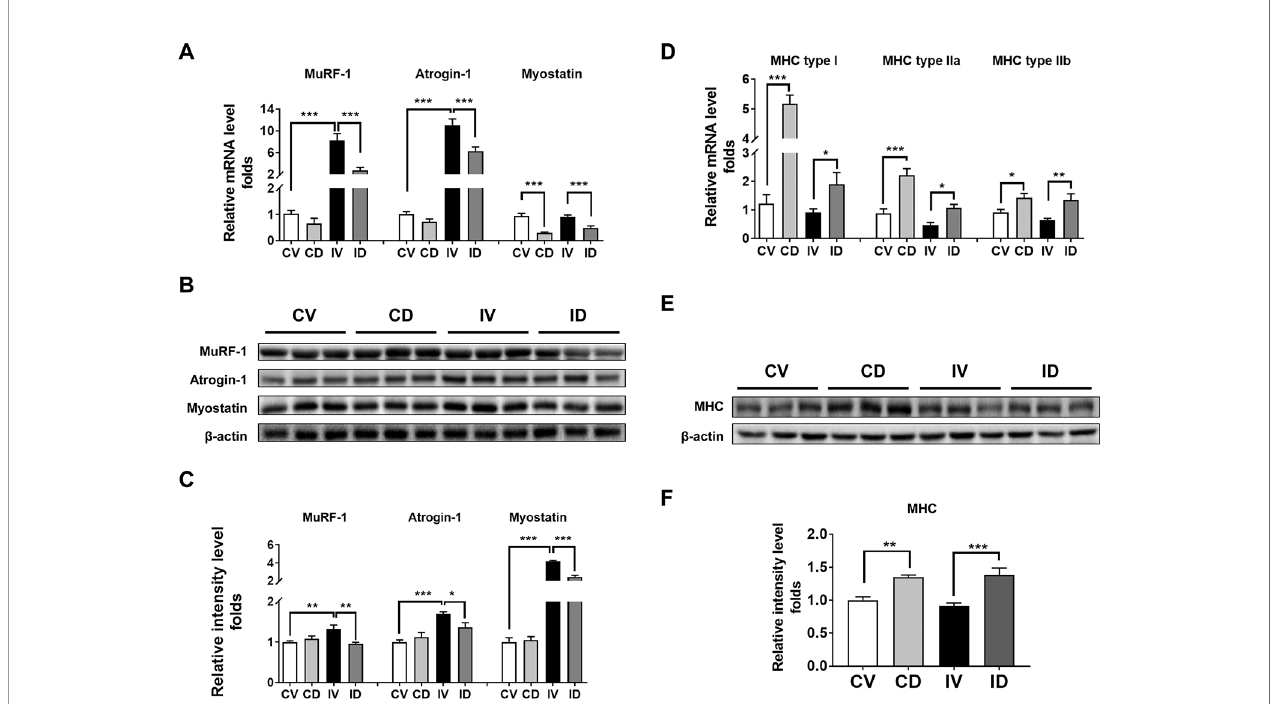
FIGURE 3 | Dulaglutide treatment decreased the mRNA and protein expression levels of degradation-related genes under disuse-induced muscle atrophy. (A) The mRNA levels of the genes encoding MuRF-1, atrogin-1, and myostatin were analyzed with RT-qPCR in GA muscle tissue, n = 5. GAPDH mRNA served as an internal control. (B) Immunoblotting and (C) quanti fi cation analyses of MuRF-1, atrogin-1, and myostatin protein expression in GA muscle. Beta-actin was used as a loading control to ensure equal protein loading, n = 3. (D) The mRNA expression of myosin heavy chain isoforms, including myosin heavy chain type I, type IIa, and type IIb, was evaluated with RT-qPCR, n = 5. GAPDH mRNA was used as an internal control. (E) Immunoblotting and (F) quanti fi cation analyses of myosin heavy chain protein expression in GA muscle. Beta-actin was used as a loading control, n = 5. Data are shown as mean ± S.E.M. *p < 0.05, **p < 0.01, ***p < 0.001 as compared with control + vehicle or immobilization + vehicle group. CV, control + vehicle; CD, control + dulaglutide; IV, immobilization + vehicle; ID, immobilization +